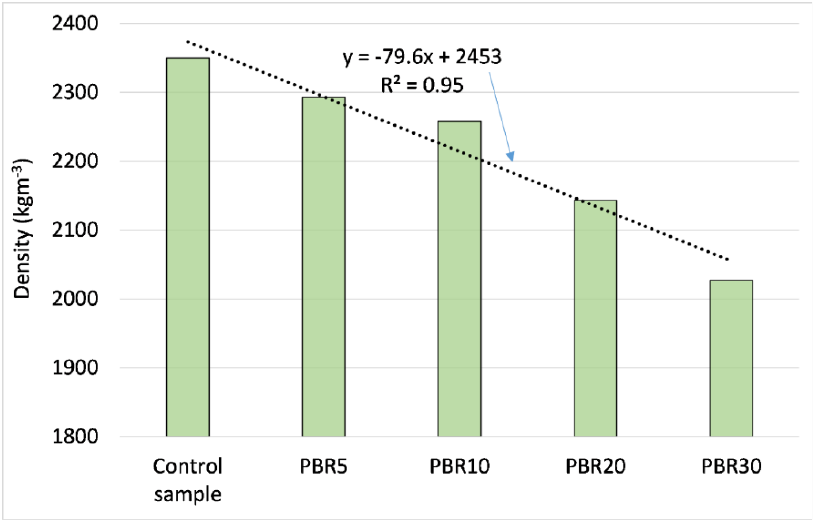
Figure 15. Density of CR IPB at 28 days.